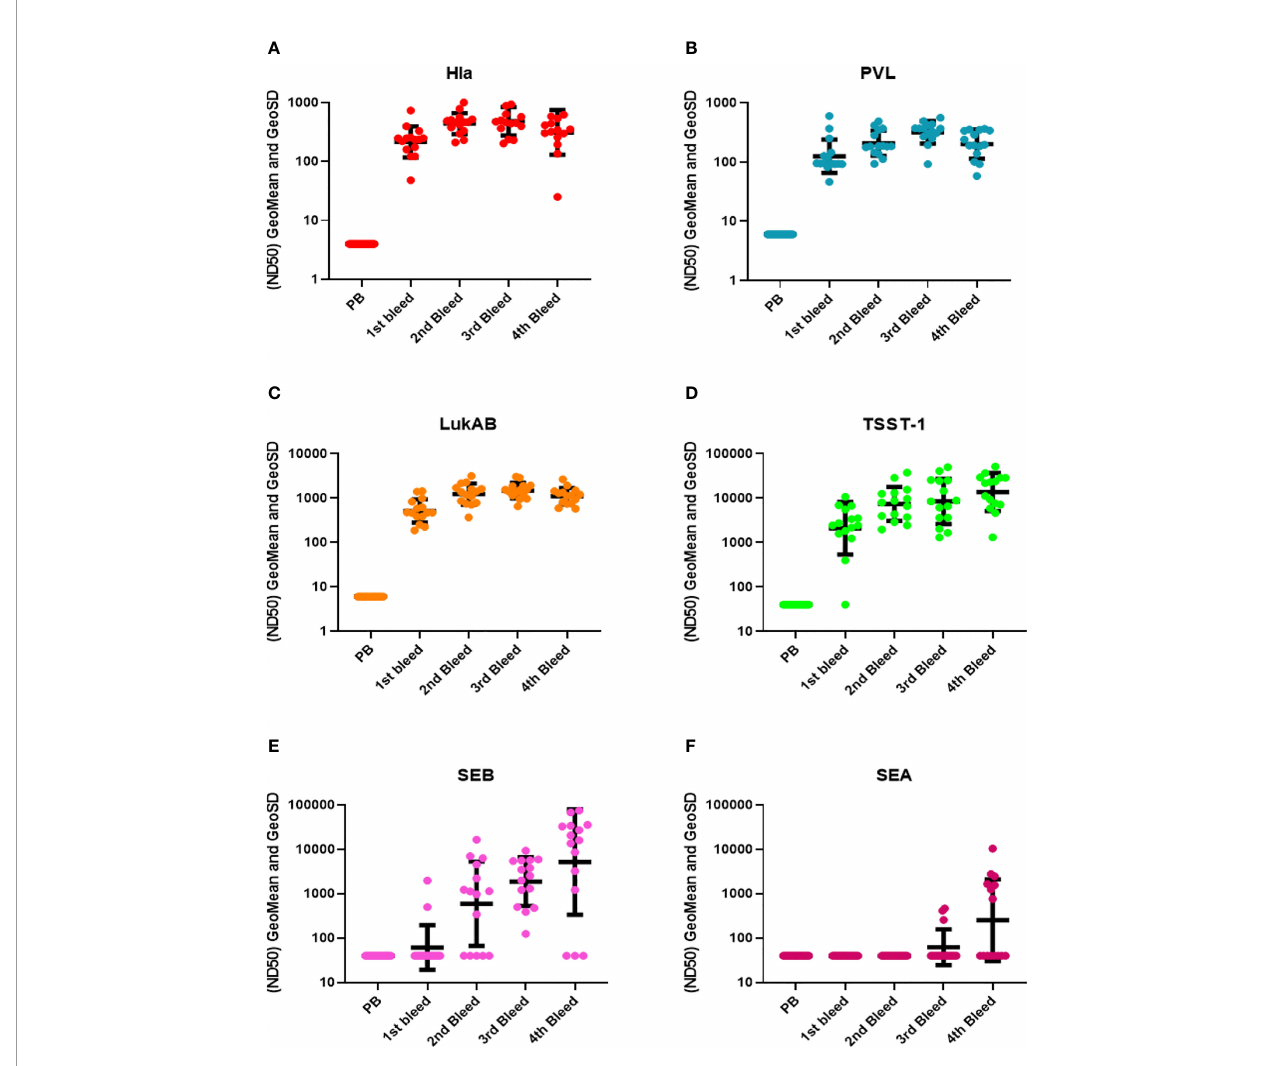
FIGURE 3 | TNA titers during rabbit immunization. The 50% neutralizing dilution (ND 50 ) for six different toxins were measured as described in materials and method sections. Neutralizing antibody titers (ND 50 s) were measured in the pre-bleed (PB) and three test bleeds along with the 4 th and fi nal terminal bleed (refer to Figure 1 ).